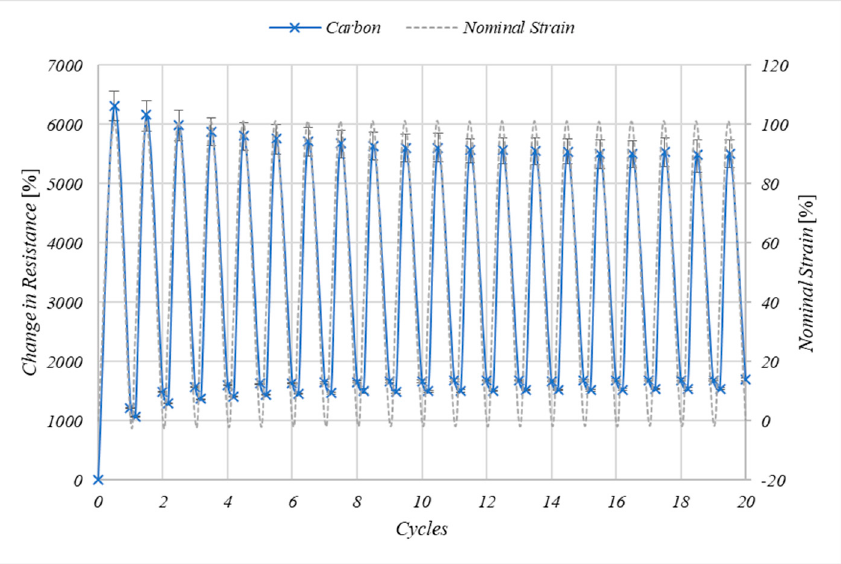
Figure 7. The effect of cyclic straining of the carbon ink to 100% nominal strain at 50 mm/min on the electrical resistance of the n = 3 samples where error bars represent the range of values.